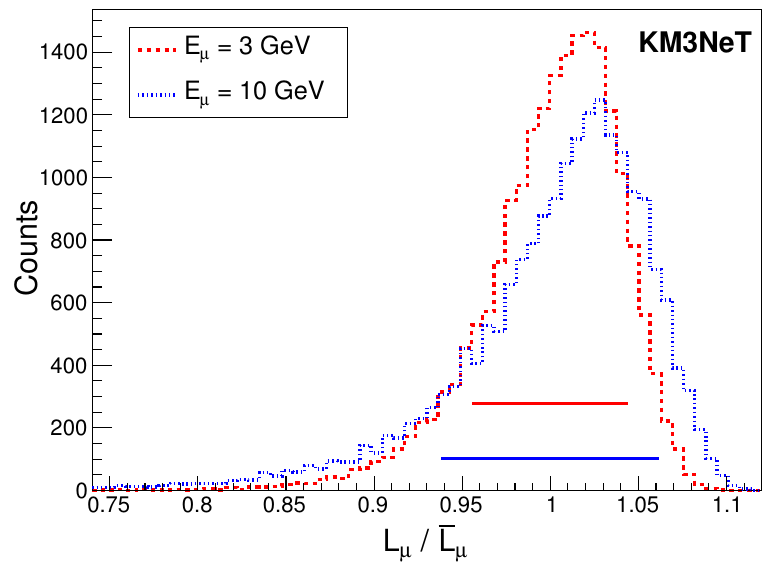
Figure 21 . Distributions of relative track length, L (cid:22) =L (cid:22) , for muons with initial energies of 3 GeV (red) and 10 GeV (blue). Horizontal bars show the mean (cid:6) the RMS. Track